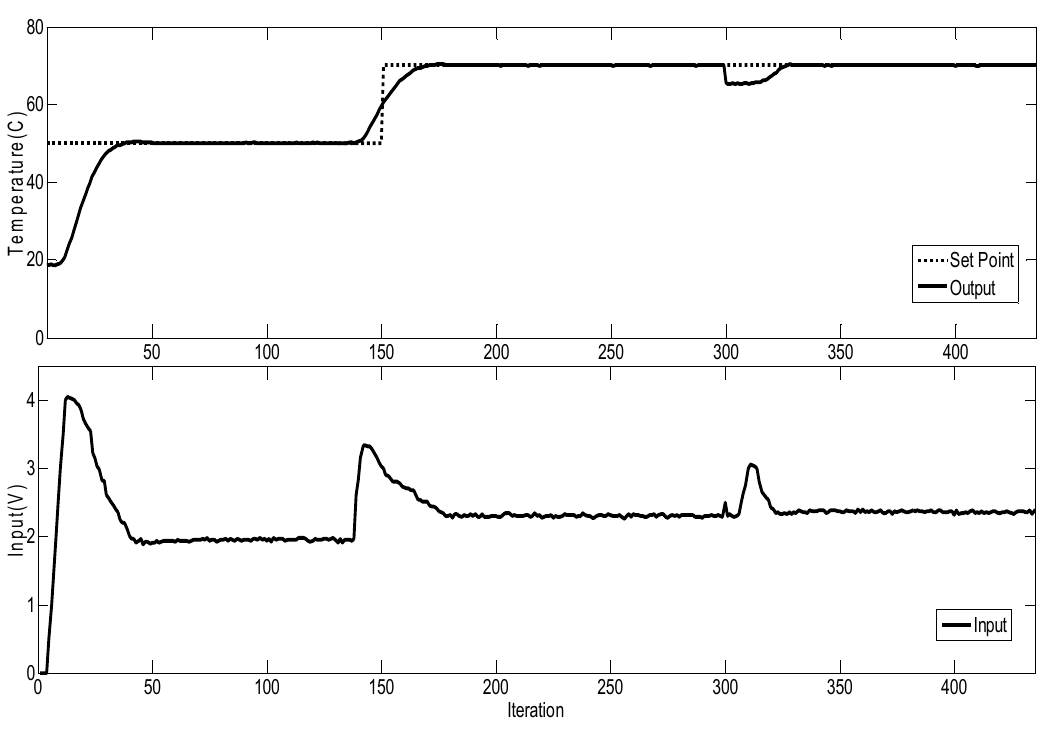
Figure 4. RFPC-GGP controller.